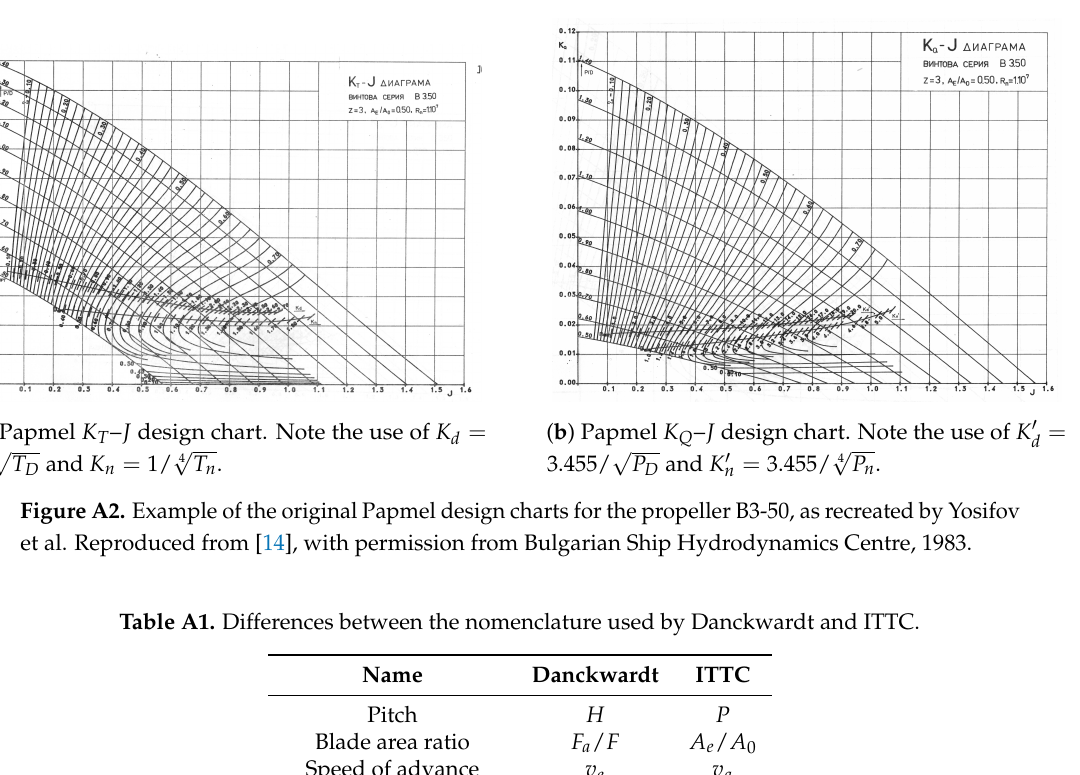
Figure A1. Example of the original Danckwardt diagrams for the propeller B3-50. See Table A1 for the differences between Danckwardt’s and ITTC’s nomenclature. Reproduced from [6].